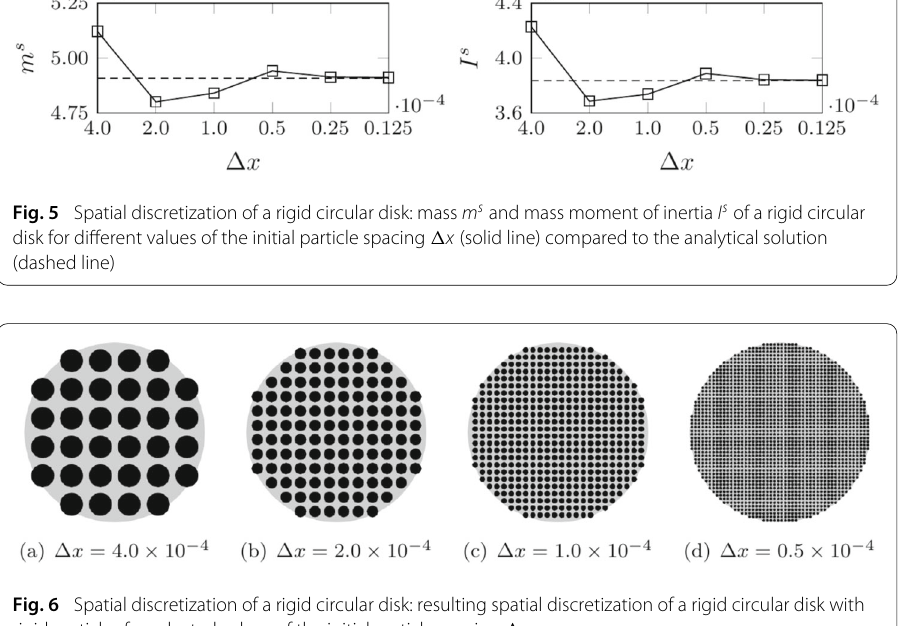
A rigid circular disk floating in a shear